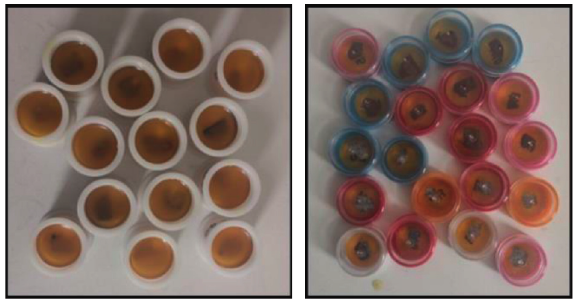
Figure 15: Prepared argillaceous sandstone samples for SEM and EDS tests.